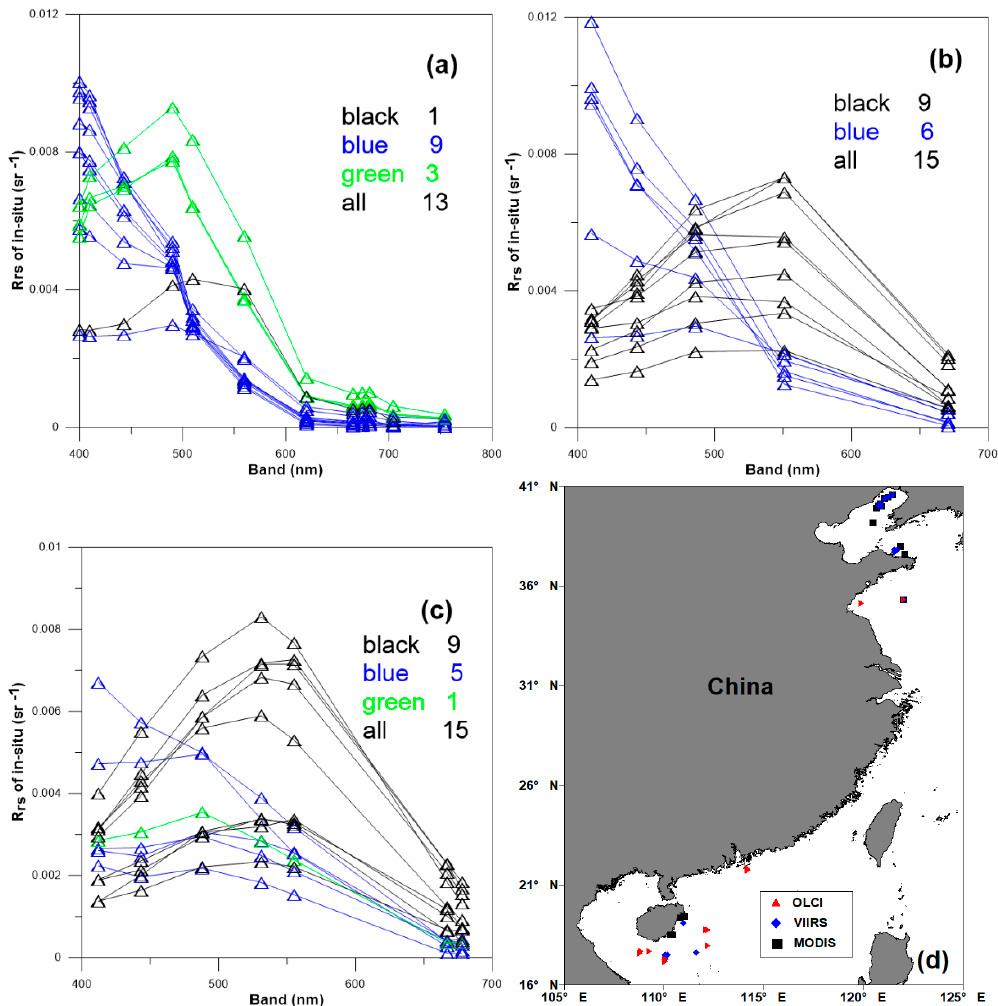
Figure 5. In-situ R rs spectra and the map of match-up stations: ( a ) OLCI, ( b )VIIRS, ( c ) MODIS, ( d ) the geographical map with the location of the match-up for each sensor. The color code is same as Figure 4.